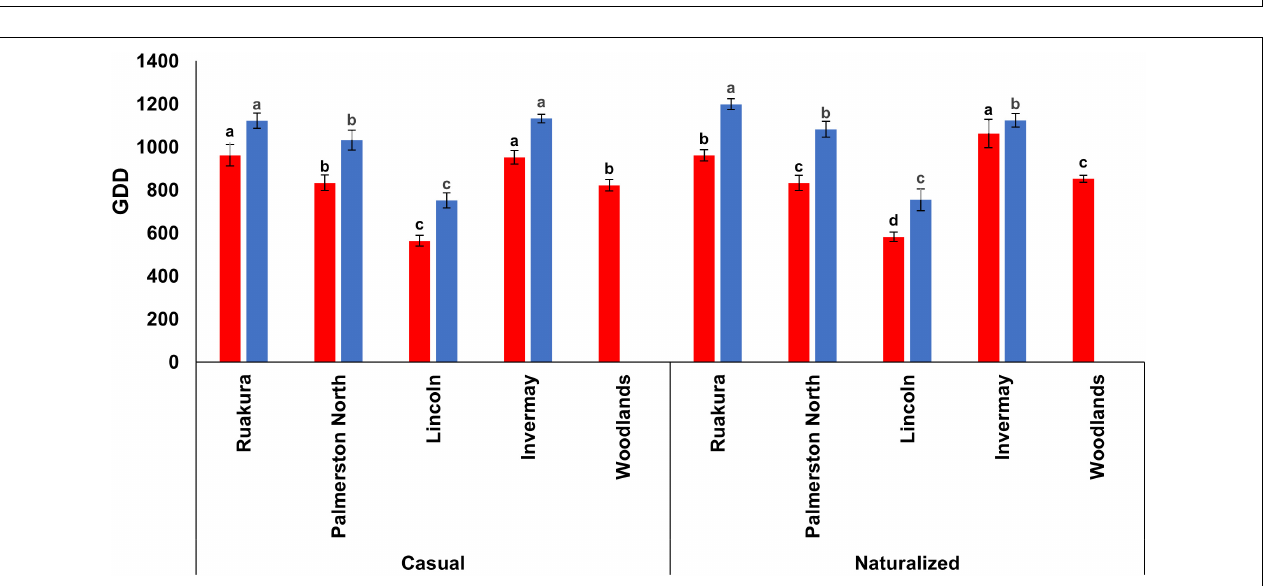
FIGURE 3 | Accumulated growing degree days (GDD) required by the casual and naturalized populations of A. theophrasti in five different regions of New Zealand to initiate flowering in the first (red bars) and second (blue bars) experiments. In the second experiment, plants in Woodlands died after emergence. For each population, vertical bars of the same colour with different letters are significantly different at 5% probability. The error bars represent ± standard error of the mean.